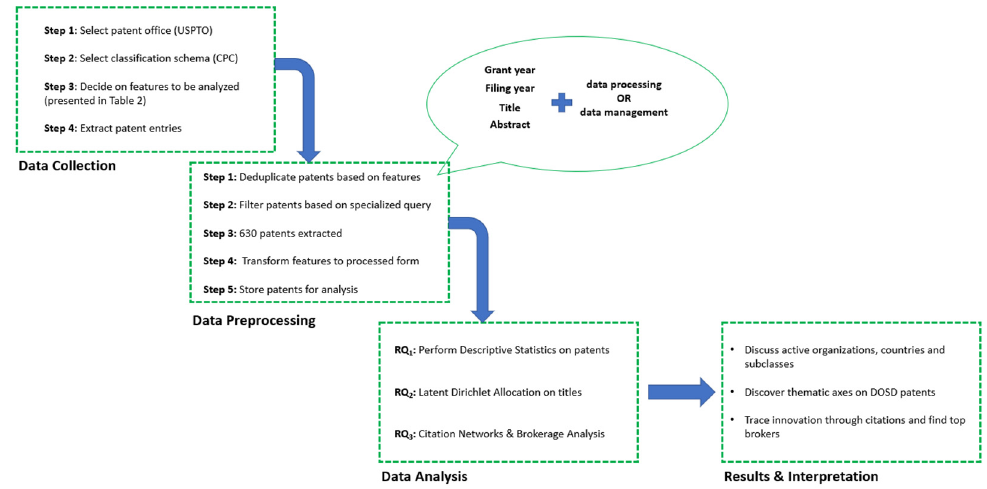
Figure 1. Methodology schema .